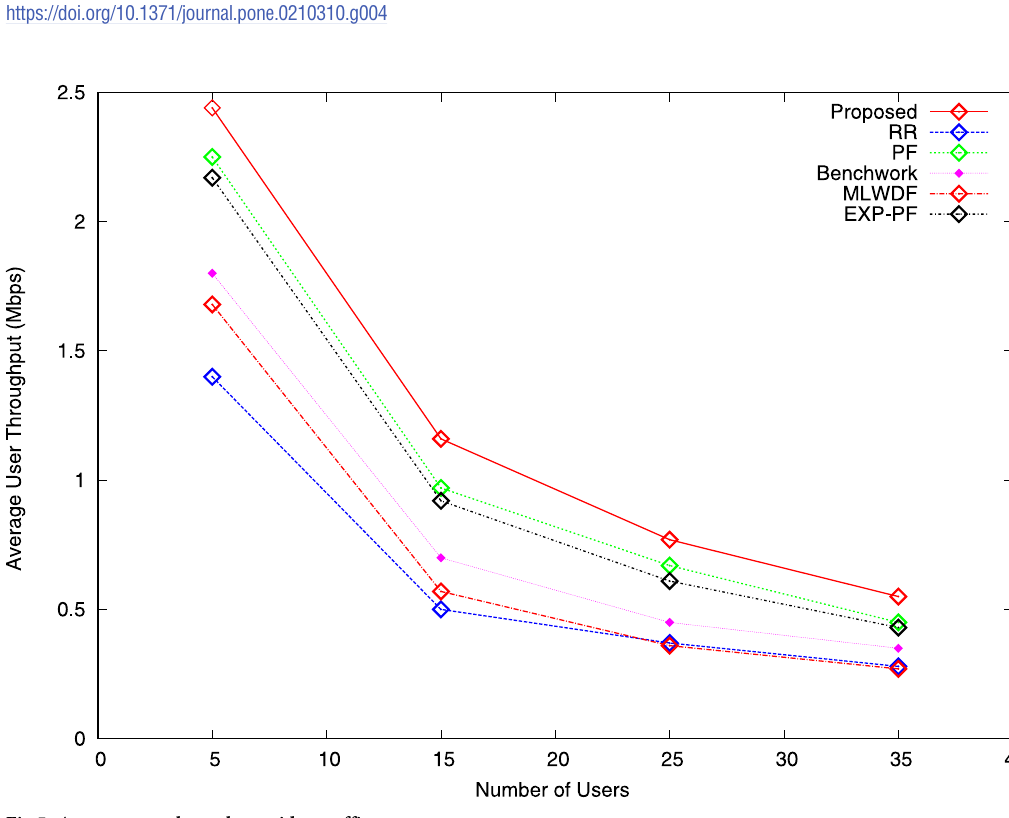
Fig 5. Average user throughput video